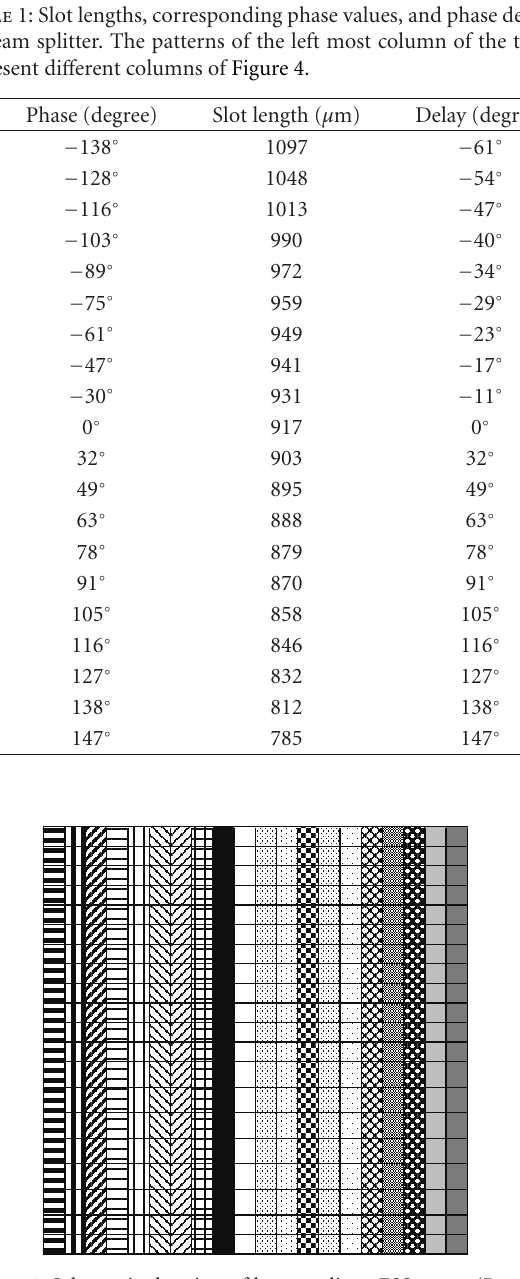
Figure 4: Schematic drawing of beam splitter FSS array. (Patterns follow the values listed in Table 1.)